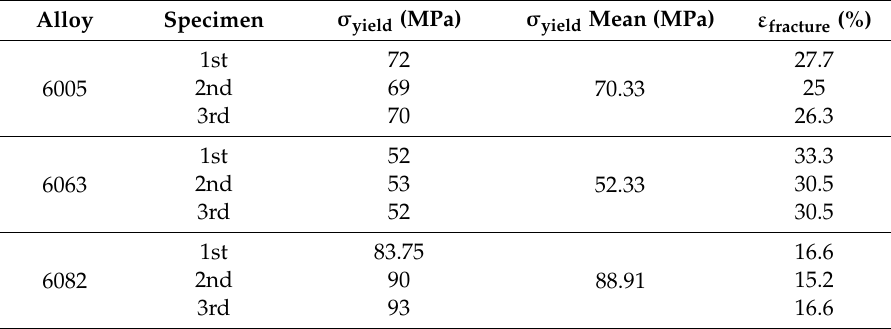
Table 5. Tensile testing results for the 6005, 6063, and 6082 Al